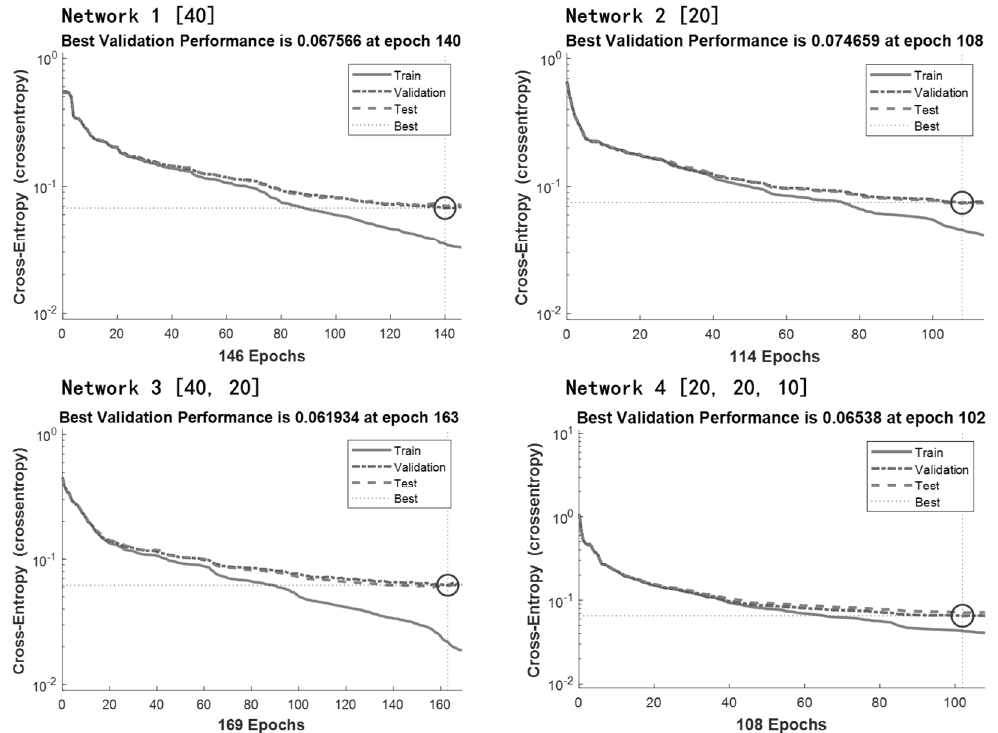
Figure 8. Output prediction error after each training cycle.